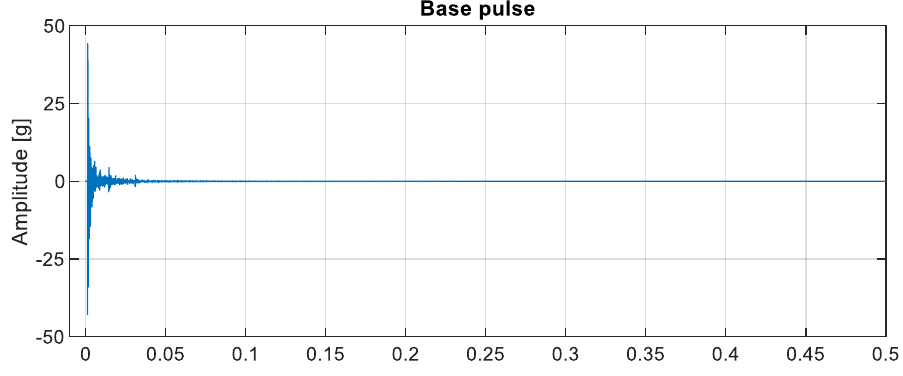
Figure 7. Full-scale base pulse.